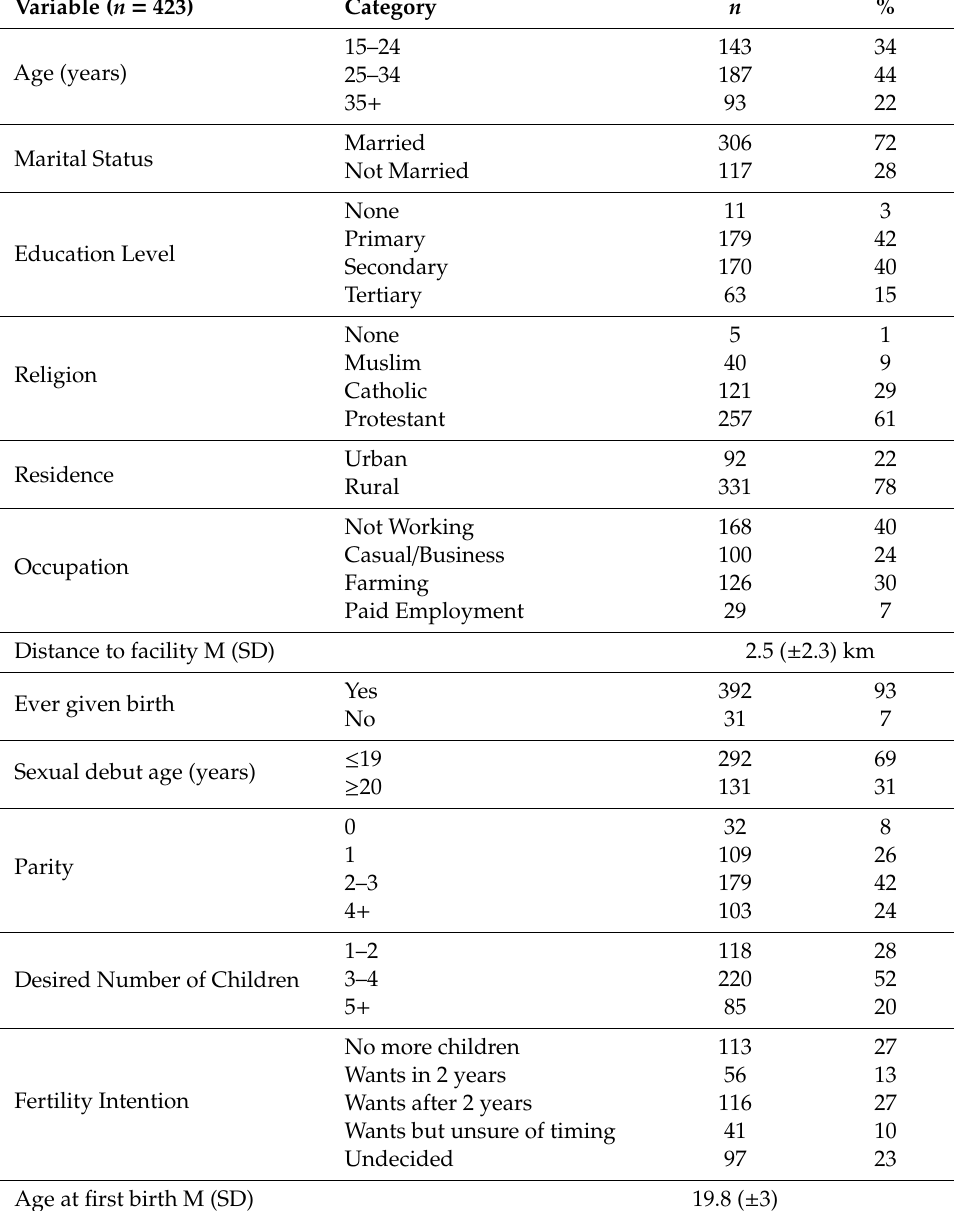
Table 1. Socio-demographic and reproductive health characteristics of